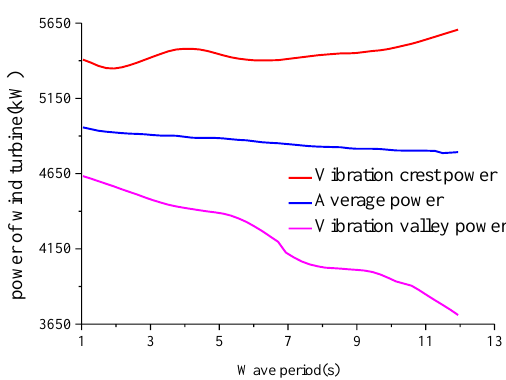
Figure 11. Comparison of the wind turbine power at different wave periods.